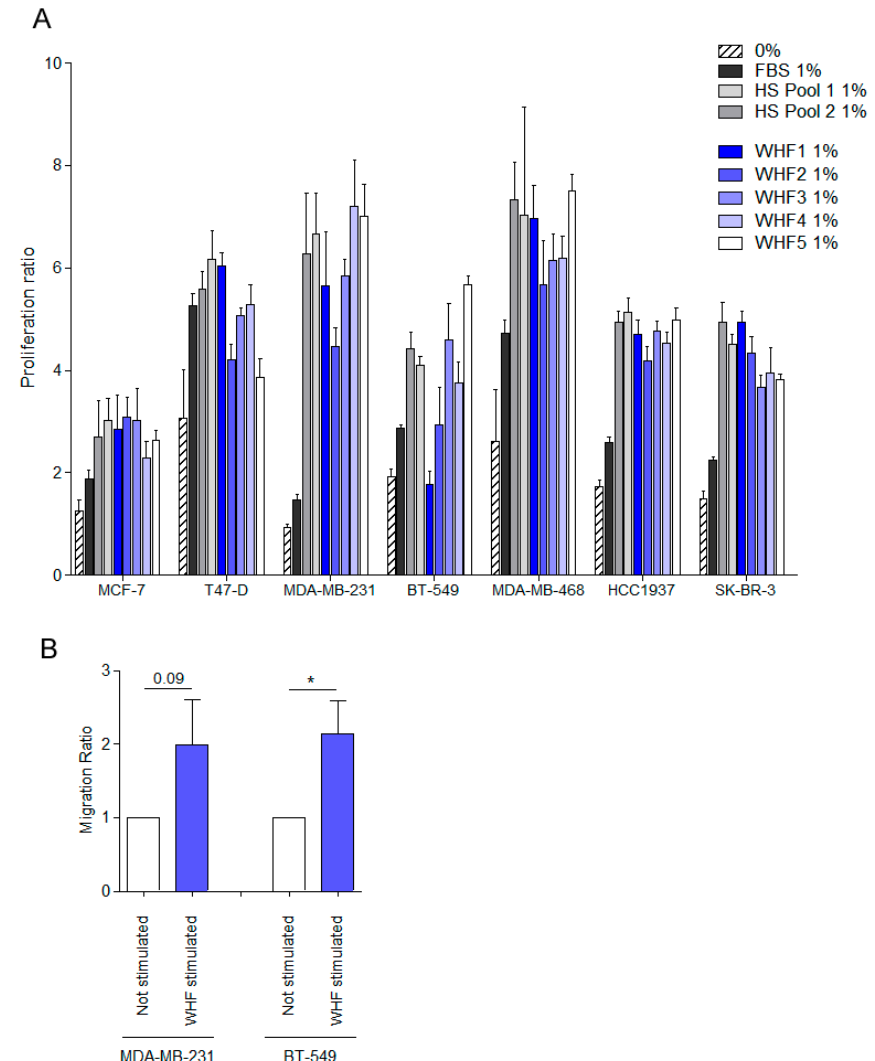
Figure 4. Effect of WHF on breast cancer cell proliferation and migration. ( A ) MCF-7, T-47D, MDA-MB-231, BT-549, MDA-MB-468, HCC1937, and SK-BR-3 breast cancer cell lines were starved